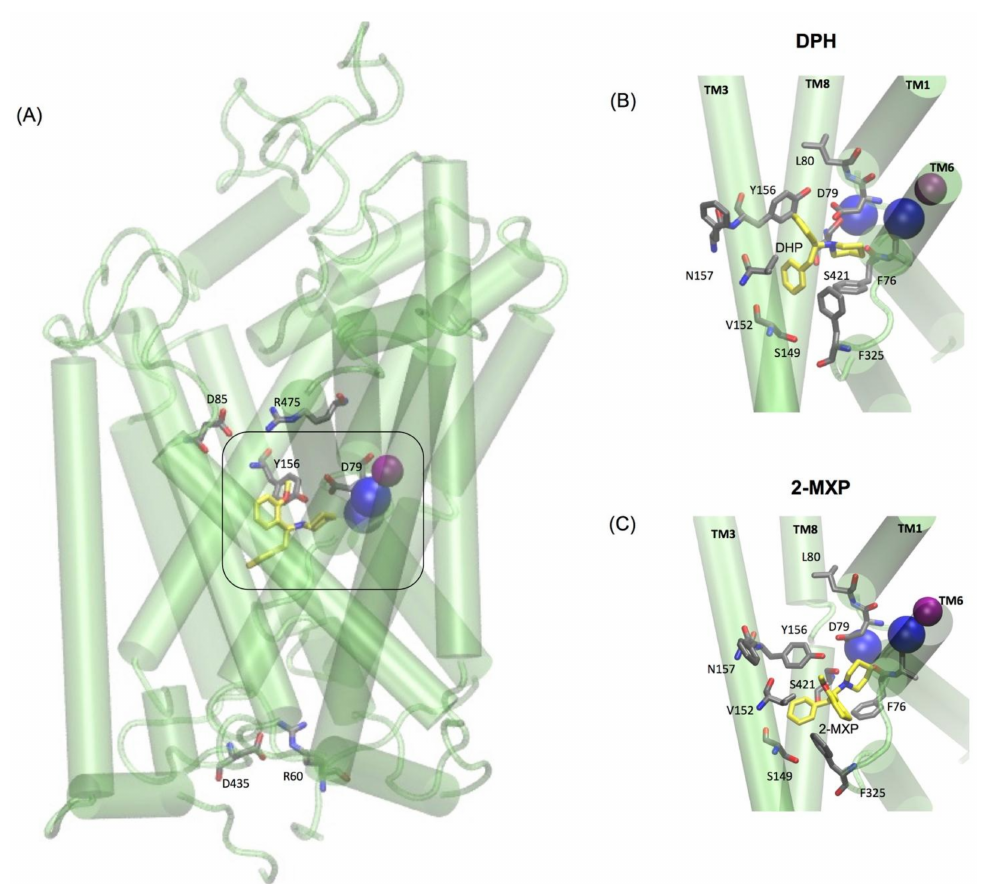
Figure 5. ( A ) Simplified representation of the molecular model of rDAT and the positions of the two oppositely charged pairs of residues, Arg 85–Asp 475 and Arg 60–Asp 435, functioning as the extracellular (EC) and intracellular (IC) gates respectively and the Asp79 and Tyr156 residues shown to be important in stabilizing the S1 binding pocket (boxed) via a hydrogen bond. rDAT in complex with ( B ) DPH (yellow) and ( C ) 2-MXP (yellow). Each of these distinct compounds occupies a binding pocket that is deeply buried in the transporter structure. Selected central binding site residues from each compound are shown in grey and labelled respectively. Additionally, blue and purple spheres represent the internal sodium and chloride ions,